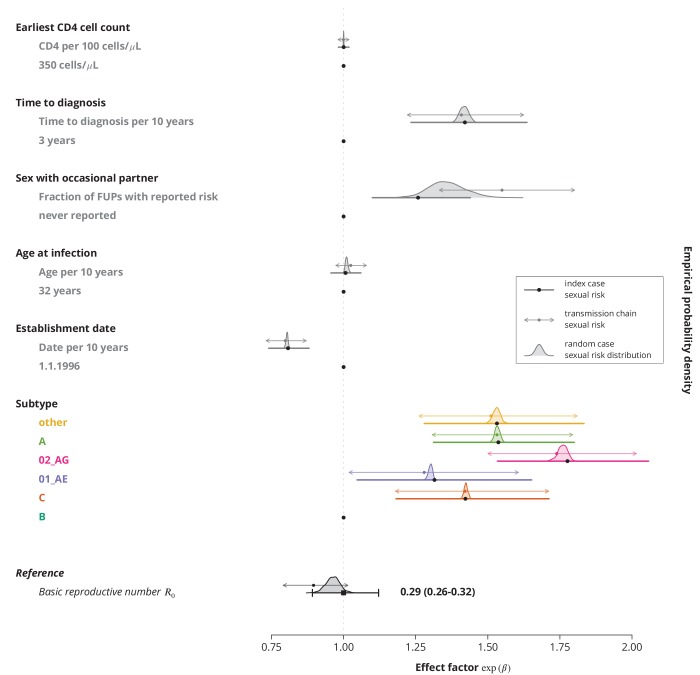
Comparison of effect sizes in the multivariate model with linear terms only for different sexual risk behavior definitions of a transmission chain.The thick lines with black circles show the original effect sizes (where the index case determined the sexual risk behavior of the transmission chain) and their 95%-confidence intervals. The empirical distribution of the effect sizes where a random individual in a transmission chain determines its sexual risk behavior is displayed by the shaded areas. The thinner horizontal double sided arrows with the filled circles correspond to the effect sizes and their 95%-confidence intervals for the transmission chain level fraction of follow-up visits (FUPs) with reported sex with occasional partner by any of the infected individuals from the transmission chain. The vertical dotted gray line depicts the reference R0 from the original model, i.e., using the index case to define the sexual risk behavior.